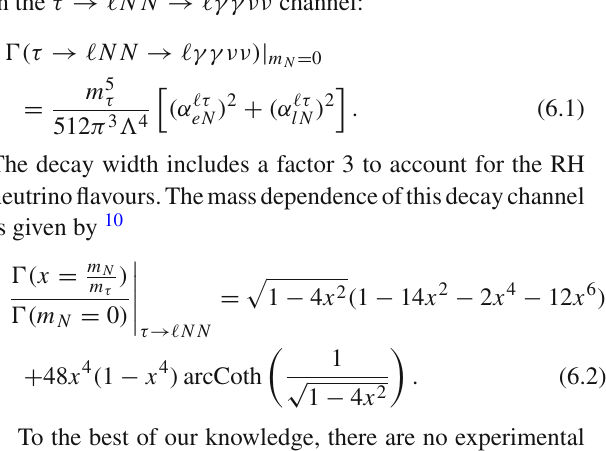
Fig. 2 RH neutrino mass dependence of the projected limits on α (cid:4)τ and α (cid:4)τ from τ decays in the τ → (cid:4) N N channel. We show the limits LN for two different assumptions on the experimental uncertainty of the branching ratio. The mass on the charged leptons has been